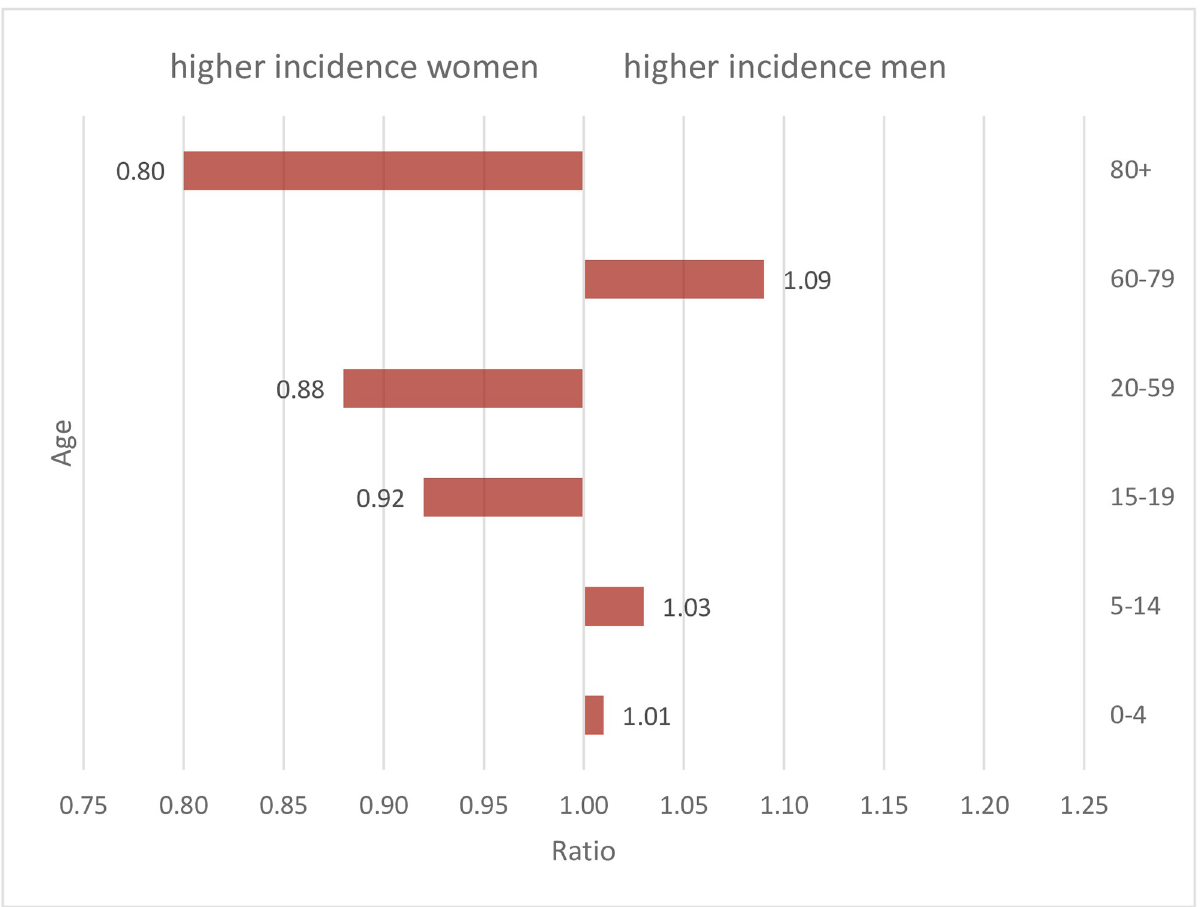
Fig 1. Sex ratios of COVID-19 incidence. Sex ratio (men/women) of COVID-19 incidence through January 5, 2021 by age (data source: Robert Koch Institute Dashboard, authors’ calculations).